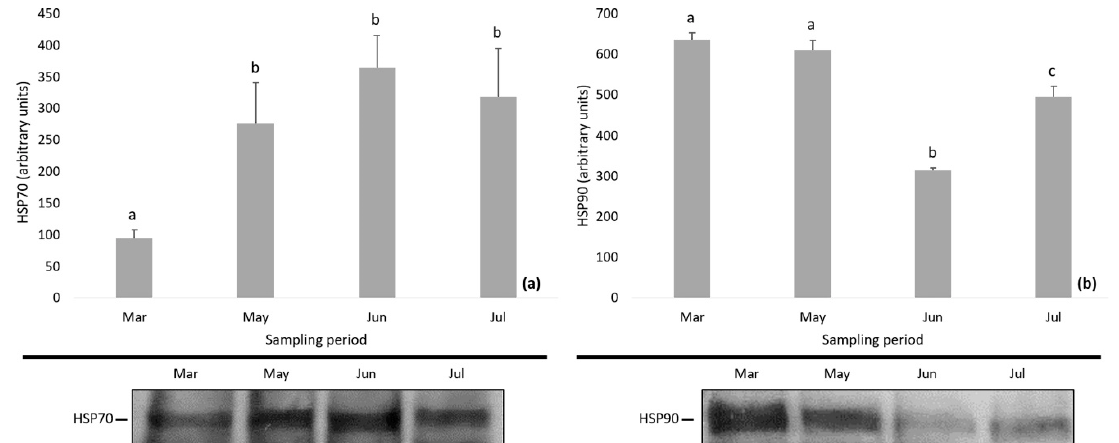
Figure 4. Expression of ( a ) HSP70 and ( b ) HSP90 in Daphnia magna during the study period. Values represent means ± SD; n = 3 technical replicates and different letter (a, b, c) denotes significant ( p < 0.05) difference between months.